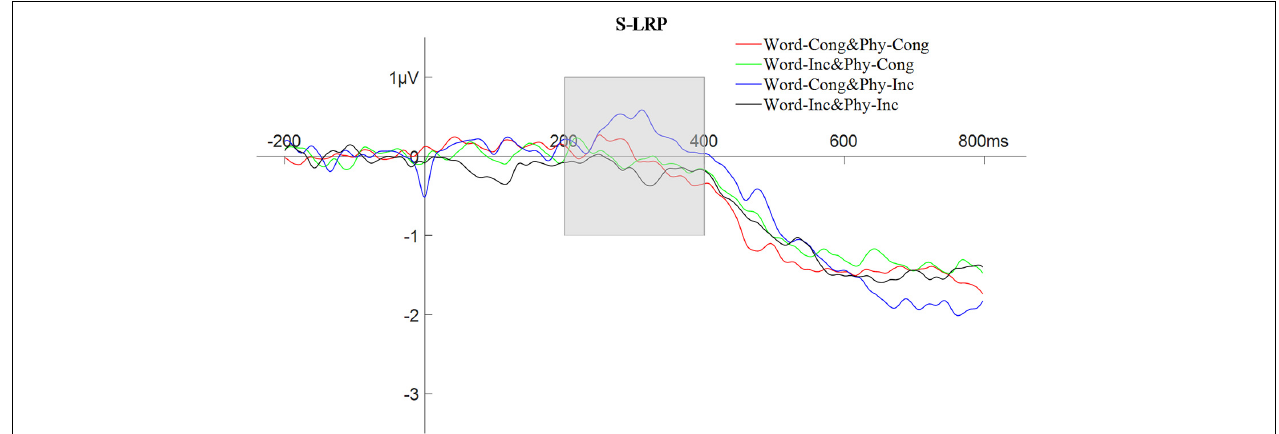
FIGURE 8 | The waveform of stimulus-locked lateralized readiness potential with word and physical congruency.